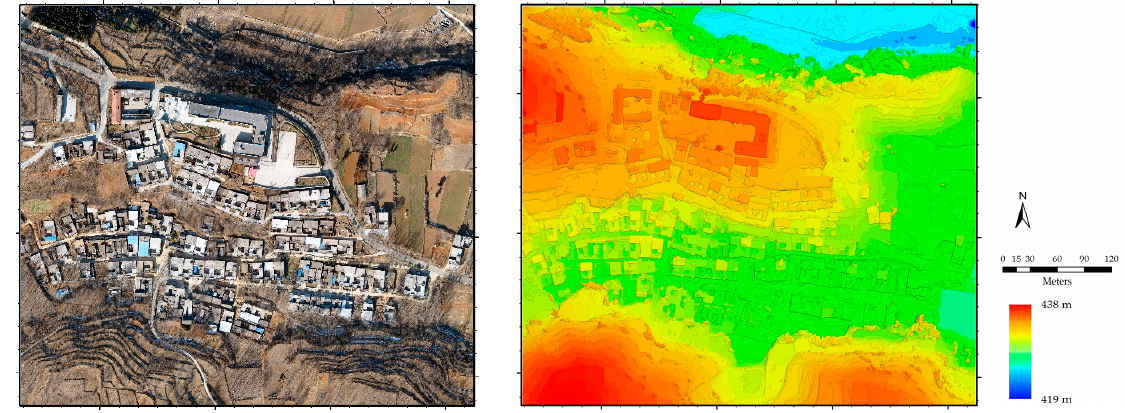
Figure 5. DOM and DSM of the study area.